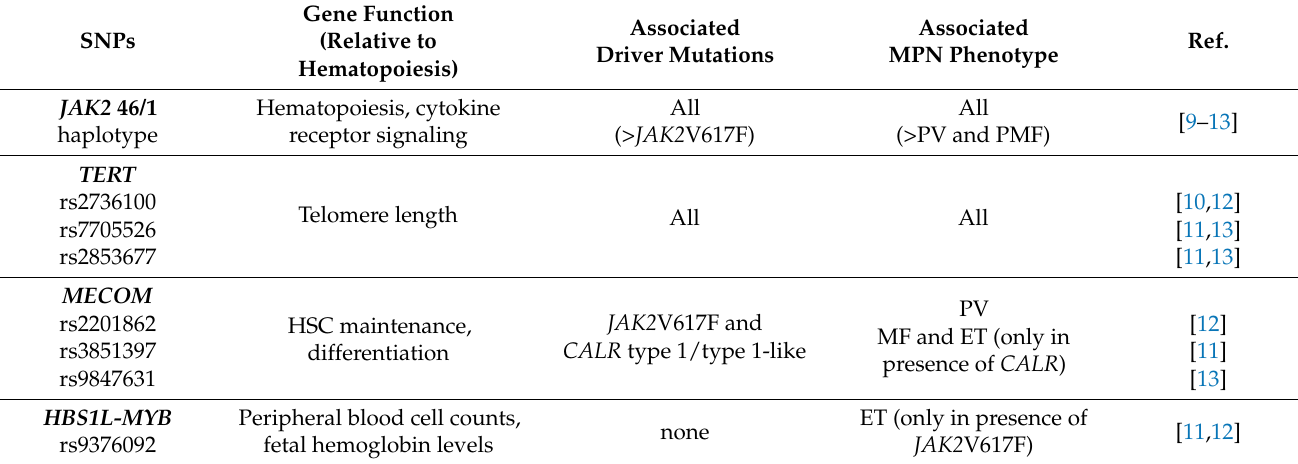
Table 1. Genome-wide significant host genetic variants defining the MPN